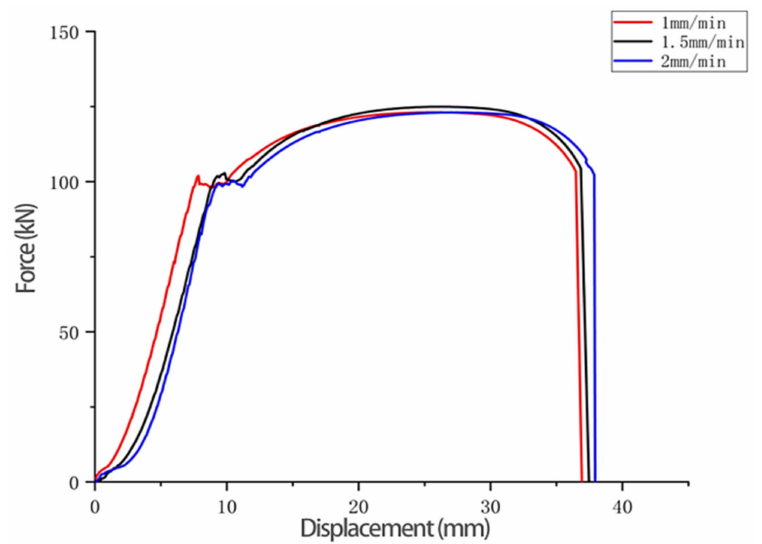
Figure 14. Tensile force and displacement curves of Q345 specimens at different rates.